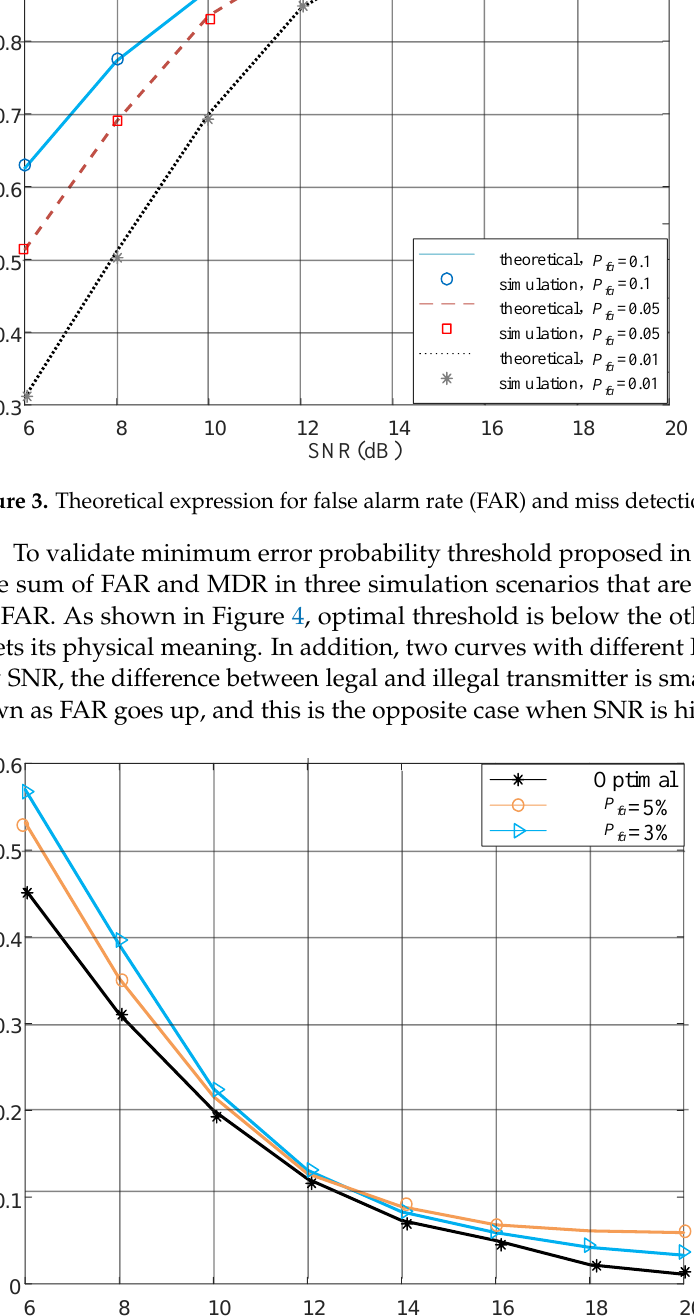
Figure 4. Authentication performance at different